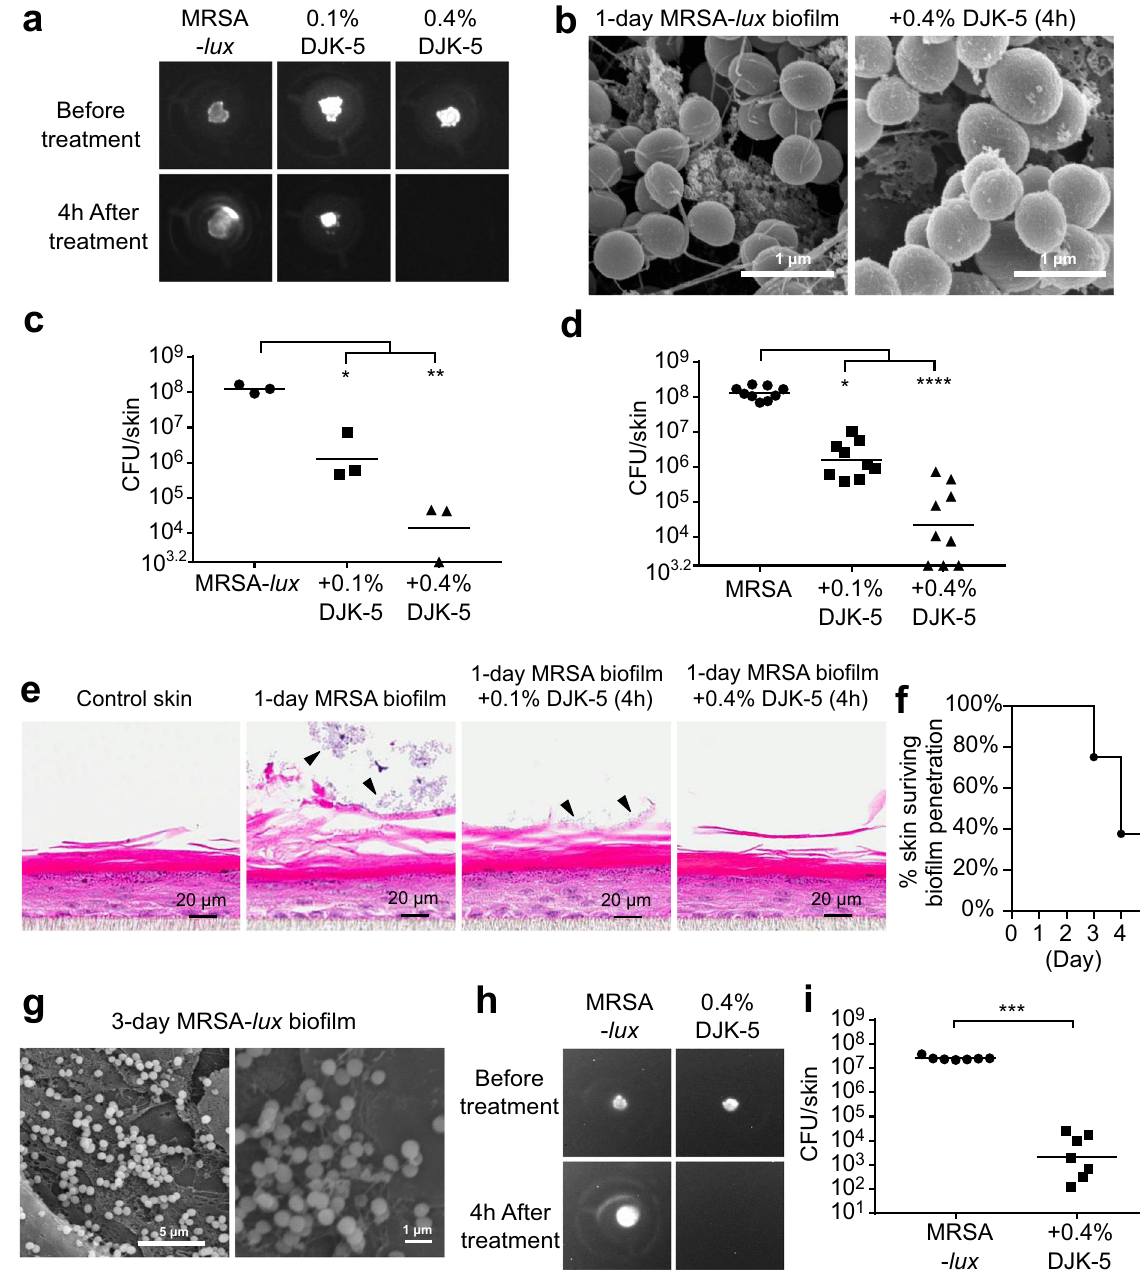
Fig. 2 DJK-5 peptide reduced 1-day and 3-day pre-established MRSA bio fi lm on the skin surface. Skin bio fi lms were established by seeding one million MRSA (USA300-LAC) or MRSA- lux (MRSA SAP149) on top of the skin. Twenty-four hours post-infection, vehicle control or DJK-5 peptide at a dosage of 0.1% (30 μ g) or 0.4% (120 μ g) was administered on top of the skin. Four hours post-treatment, DJK-5 peptide reduced luminescence from skin colonized with MRSA- lux ( a ) and decreased total bacteria recovered from skin infected with MRSA- lux ( c ) and MRSA ( d ). Bio fi lm structures for MRSA- lux with or without DJK-5 treatment were visualized by SEM ( b ) and H&E staining ( e ). For the long-term study, MRSA- lux bio fi lm was imaged every 24 h after initial inoculation, ( f ) shows number of days that a con fi ned bio fi lm can be maintained on top of the skin without bypassing the skin barrier resulting in bacterial growth in the culture media below the fi lter insert (raw data shown in Supplementary Figure 1a). MRSA- lux 3-day bio fi lm was visualized by SEM ( g ) and treated with 0.4% DJK-5 for 4 h, which reduced luminescence ( h ) and CFU recovered ( i ) compared to untreated samples. Statistical signi fi cance (* P ≤ 0.05; ** P ≤ 0.01; *** P ≤ 0.001; **** P ≤ 0.0001) was determined using the Kruskal – Wallis test, Dunn ’ s multiple comparisons test ( c , d ), or the Mann – Whitney test ( i ). Geometric mean of CFU count from 3 to 9 biological replicates as indicated in ( c , d , i